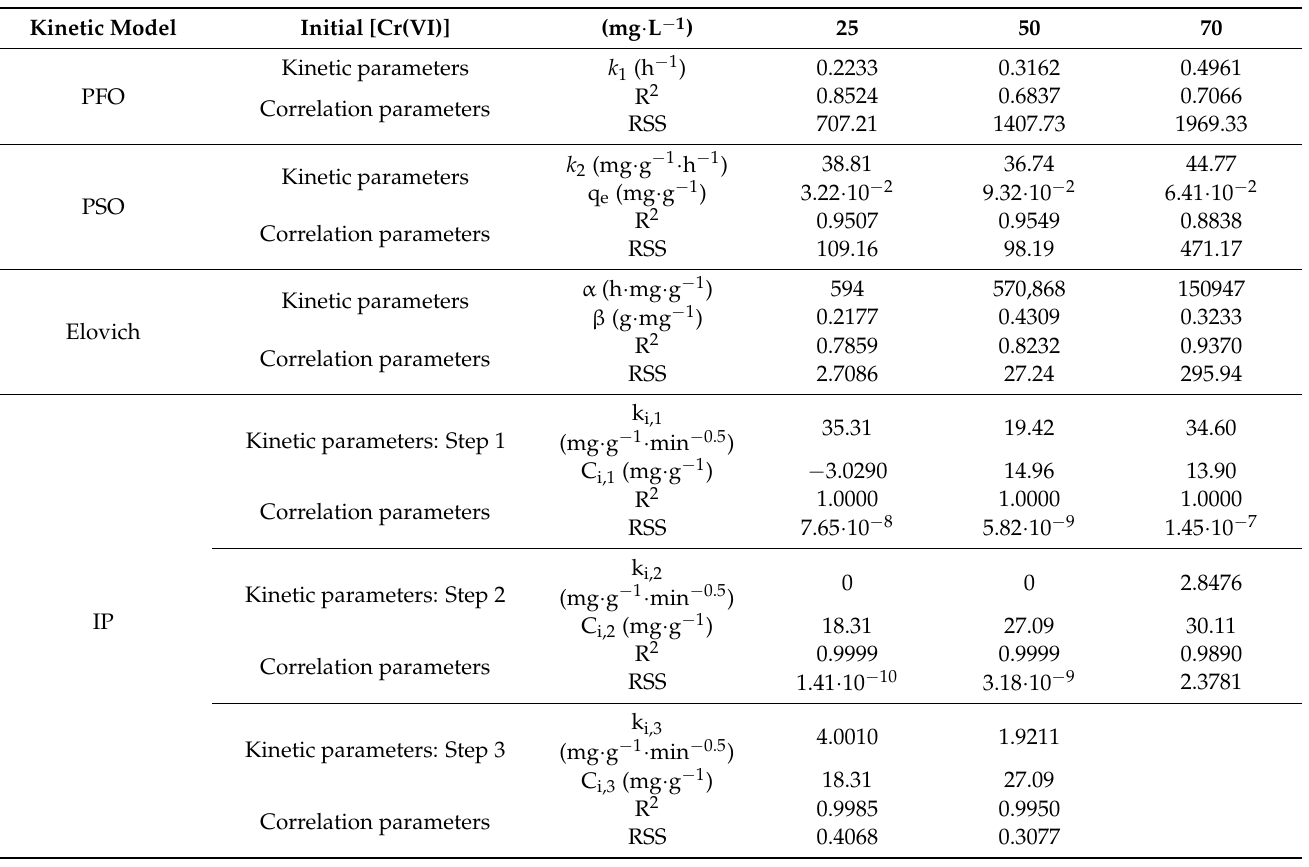
Table A4. Adjusted kinetic and correlation parameters of different kinetic models fitted to the experi- mental data of initial chromium concentration (25-70 mg · L − 1 ) adsorption of hexavalent chromium onto CCNC (cont.).